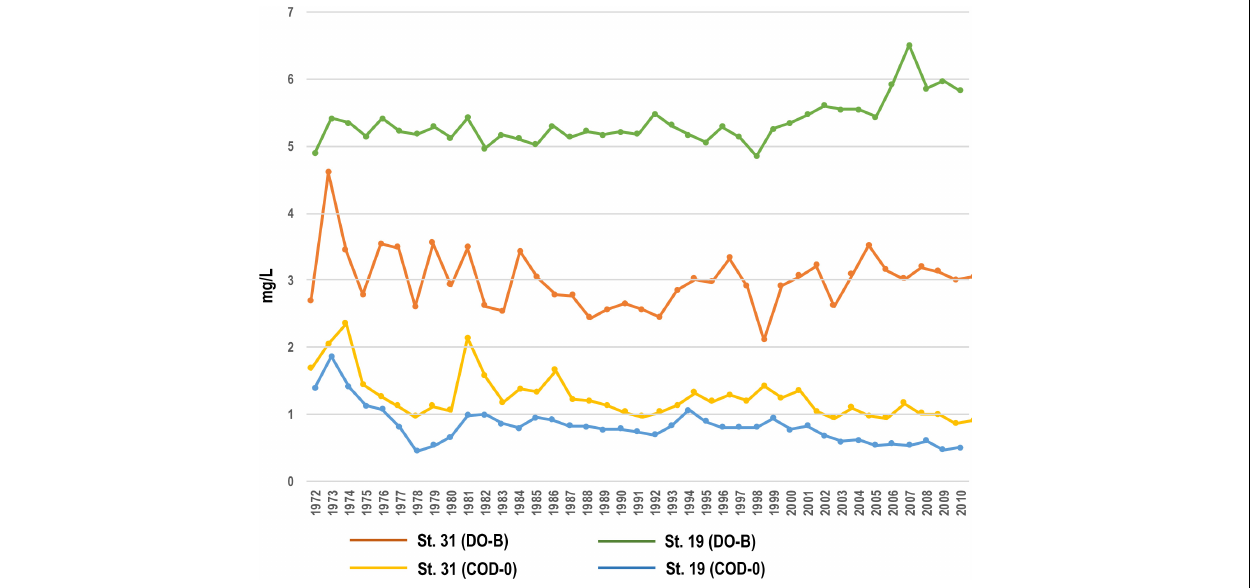
FIGURE 9 | Temporal changes of DO and COD at the inner (St. 31) and mouth (St. 19) parts of Beppu Bay.